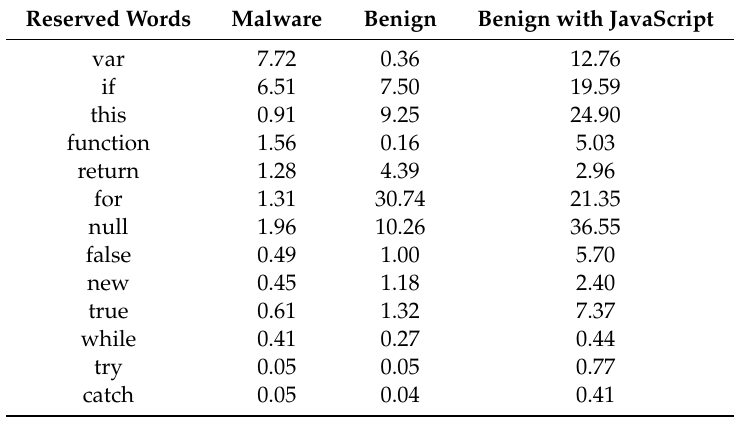
Table 4. The average count of each reserved word in JavaScript.